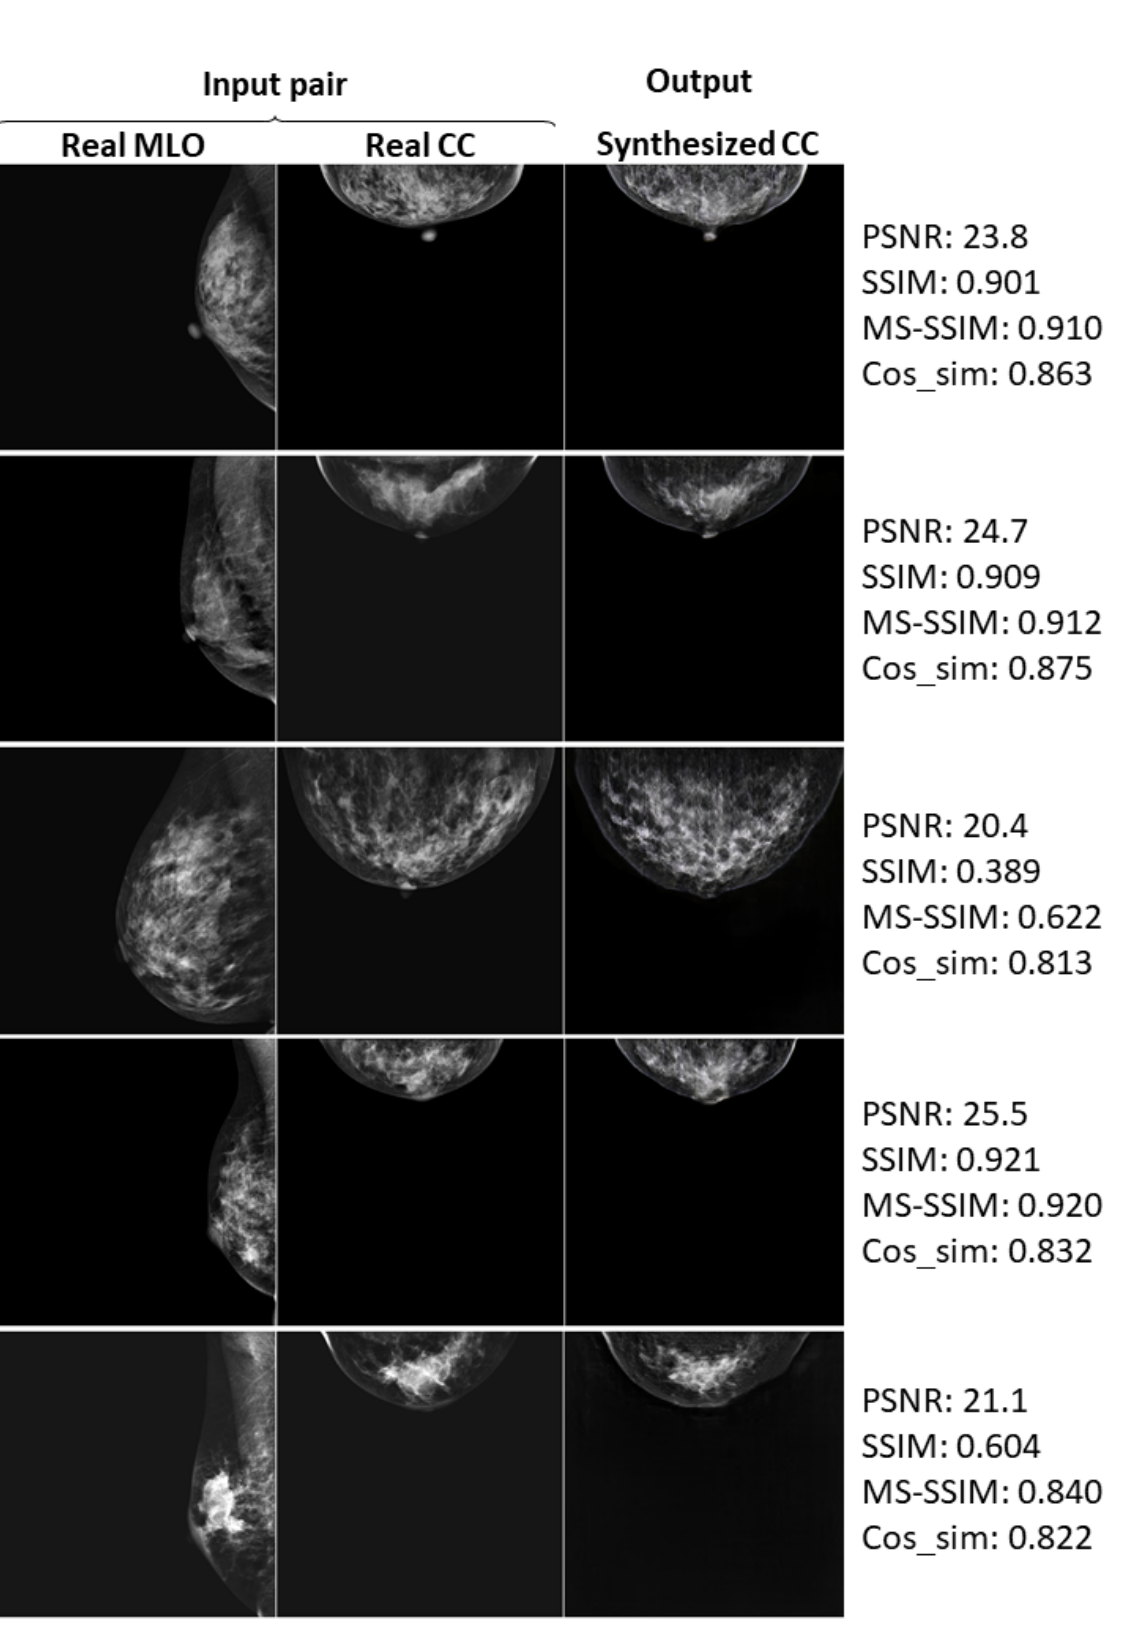
Figure A3. Real and synthesized CC-view mammograms at 512 × 512 resolution: further